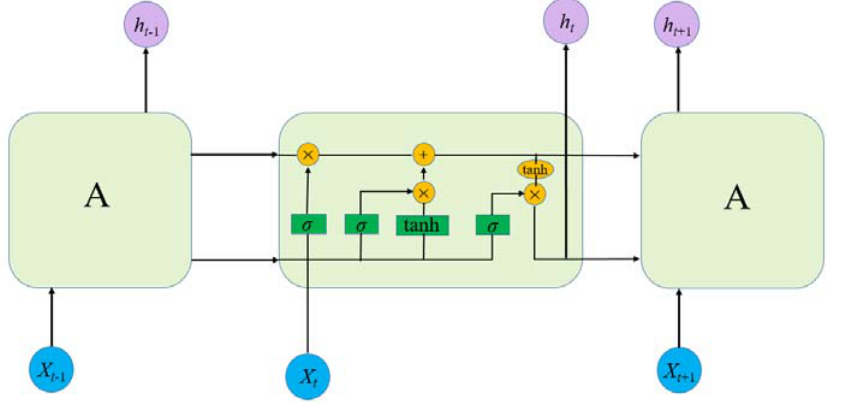
Figure 3. Structural diagram of LSTM model.